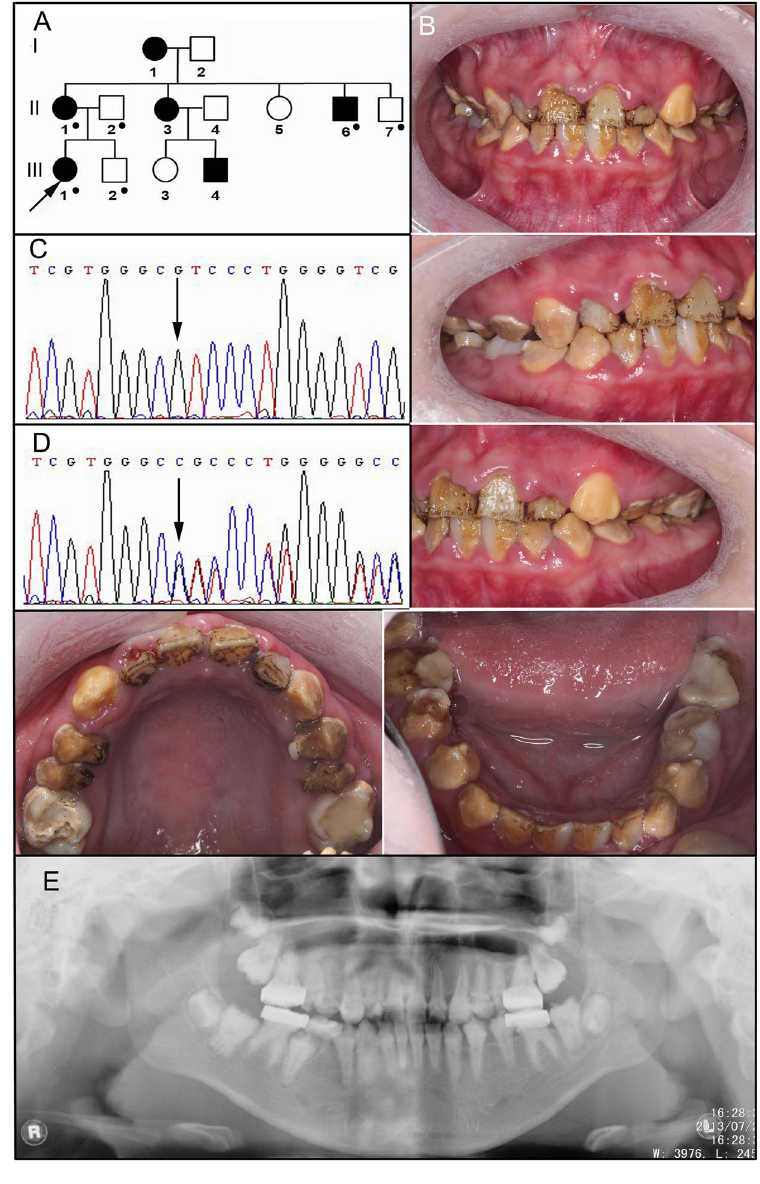
Figure 1. Clinical and mutational analysis of Family 1. ( A ) Pedigree of Family 1, Proband (III:1). Black dots indicate members recruited for this study. ( B ) Oral photographs showing enamel malformations categorized as hypocalcified AI. ( C , D ) FAM83H exon 5 sequencing chromatogram of an unaffected family member (II:7) ( C ), and the proband (III:1) ( D ), revealing a novel frameshift mutation: c.931dupC, p.V311Rfs * 13. ( E ) Panoramic radiograph of the proband taken at the age of